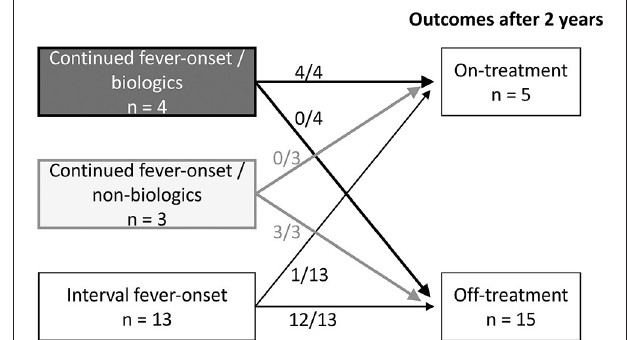
FIGURE 2 | The treatment outcomes of three group-patients with KD-related arthritis. Information of the treatment outcomes of KD-related arthritis was available for 4 of 7 continued fever-onset patients /biologics, 3 of 11 continued fever-onset /non-biologics patients, and 13 of 22 interval fever-onset